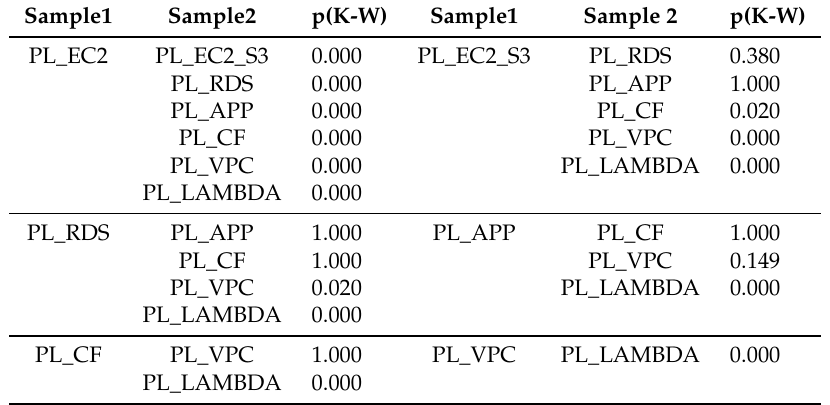
Table 5. Comparative study of progress in all the lab activities with respect to the subsequent ones.